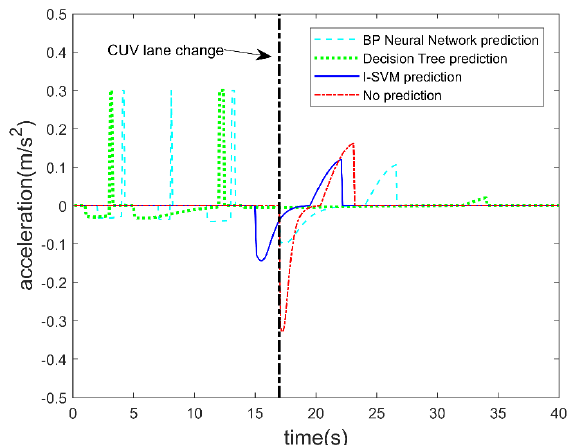
Figure 11. Acceleration of the autonomous vehicle with interference of CUV lane changing at 17th second.